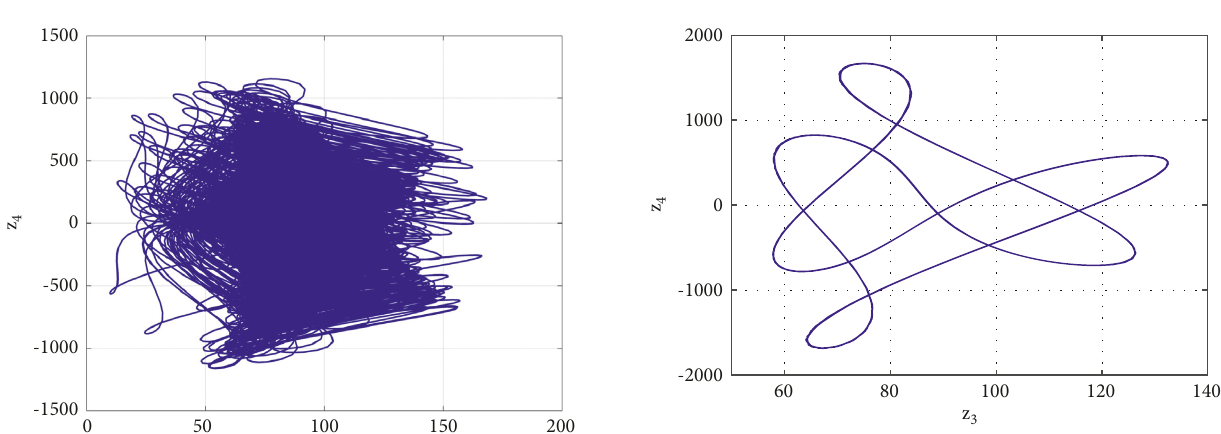
Figure 25: A periodic attractor of the model (1) for d � 1020 and ( a, b,c ) � ( 25 , 8 , 90 ) . Figure